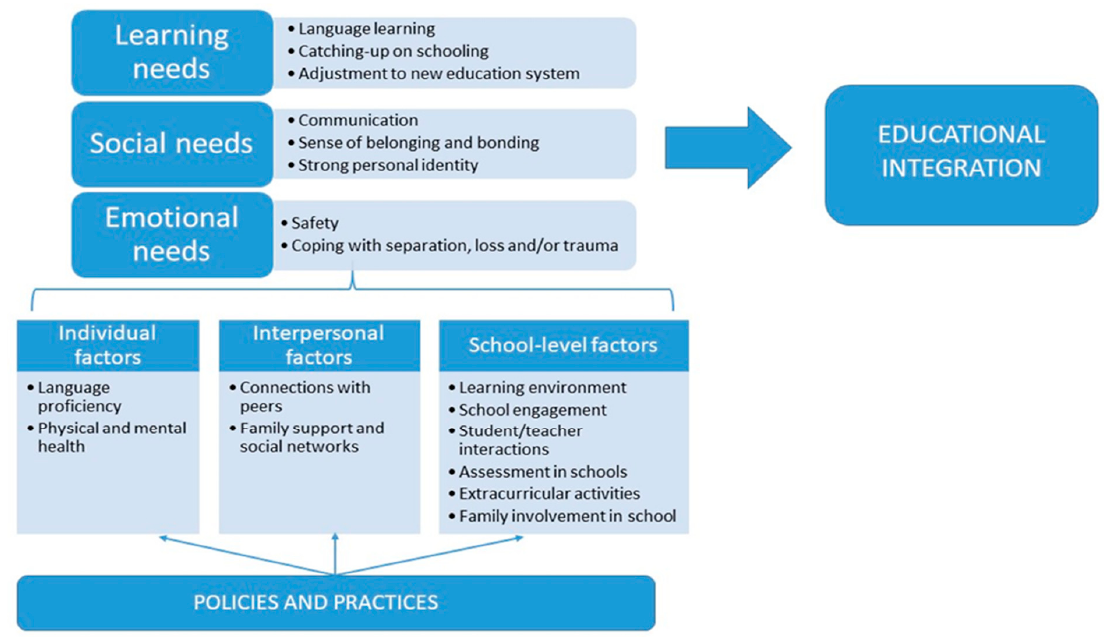
Figure 1. A holistic model for the educational integration of refugee children [24]. Table 1. Selected factors influencing refugee